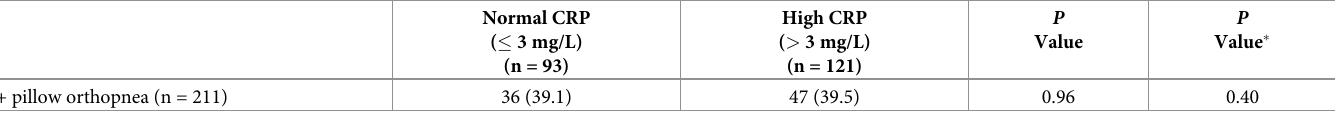
Abbreviations: ACE: Angiotensin converting enzyme, ARB: Angiotensin receptor blocker, CITP: C-telopeptide for type I collagen, COPD: Chronic obstructive pulmonary disease, CRP: C-reactive protein, CV: Cardiovascular, HF: Heart failure, Hs: High-sensitivity, JVP: Jugular venous pressure, MLHFQ: Minnesota Living with